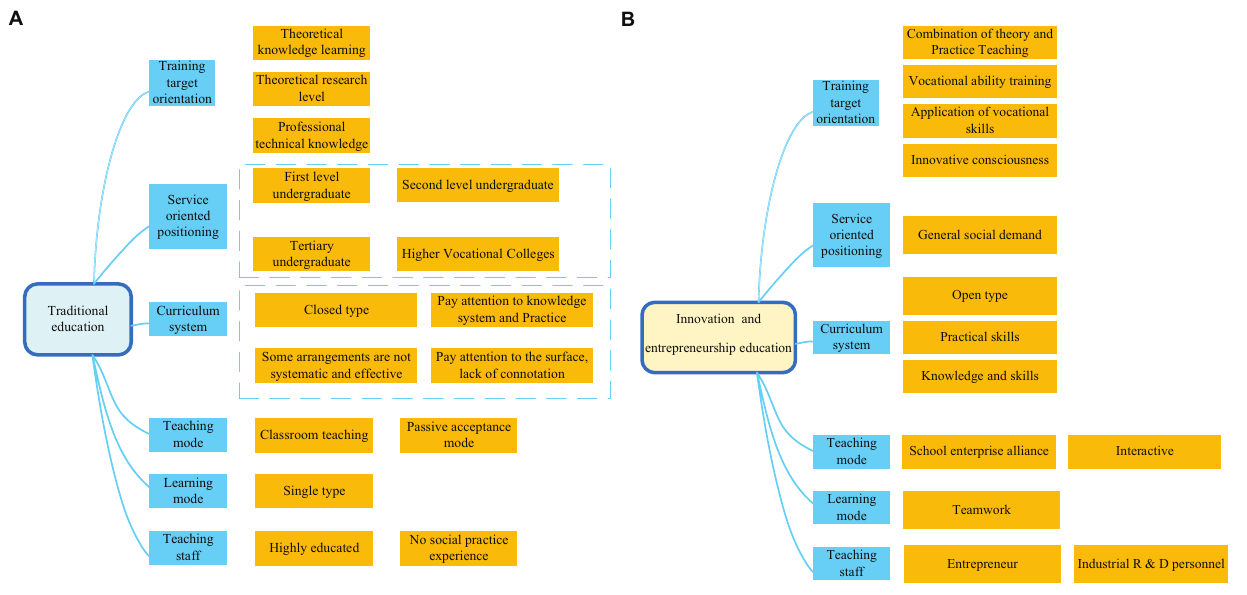
FIGURE 1 | Comparative chart of traditional education and innovation and entrepreneurship education (IEE) in colleges. (A) Traditional education; (B)